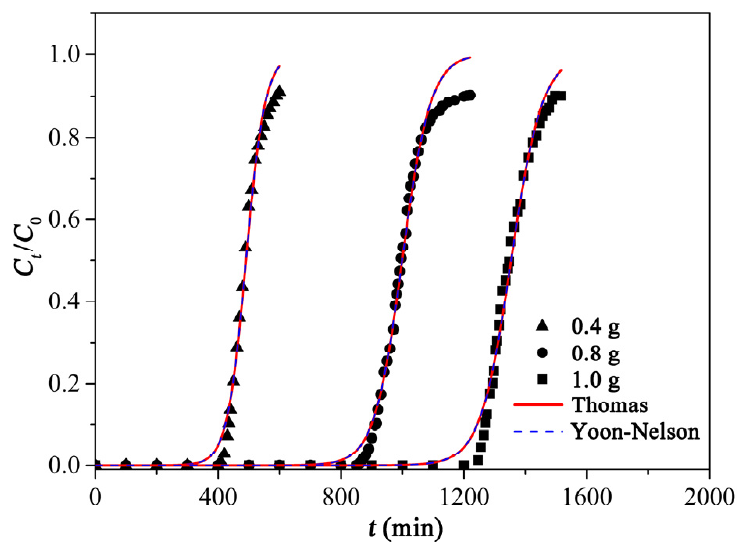
Figure 10. Breakthrough curves of RhB adsorption on PCAC with mass of 0.4 g, 0.8 g, and 1.0 g. The experimental data fit with the nonlinear Thomas model and the Yoon–Nelson model. Table 5. Experimental data of the column parameters (Diameter of column, 1.2 cm; flow rate,